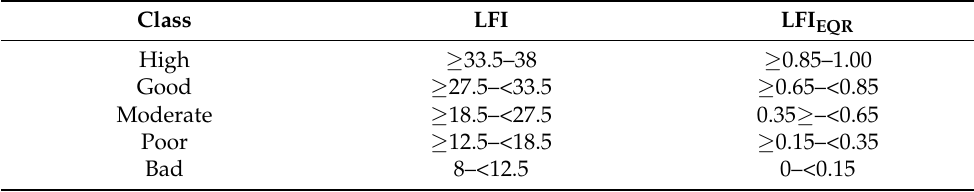
Table 4. The distribution range of LFI’s ecological limits in each class, according to Franco et al. [3] and Sapounidis et al. [38]. The column “LFI” provides the ecological limits using the total scores of the proposed index, while LFI EQR provides the limits among the classes after the transformation of LFI scores to EQR based on the requirements of the